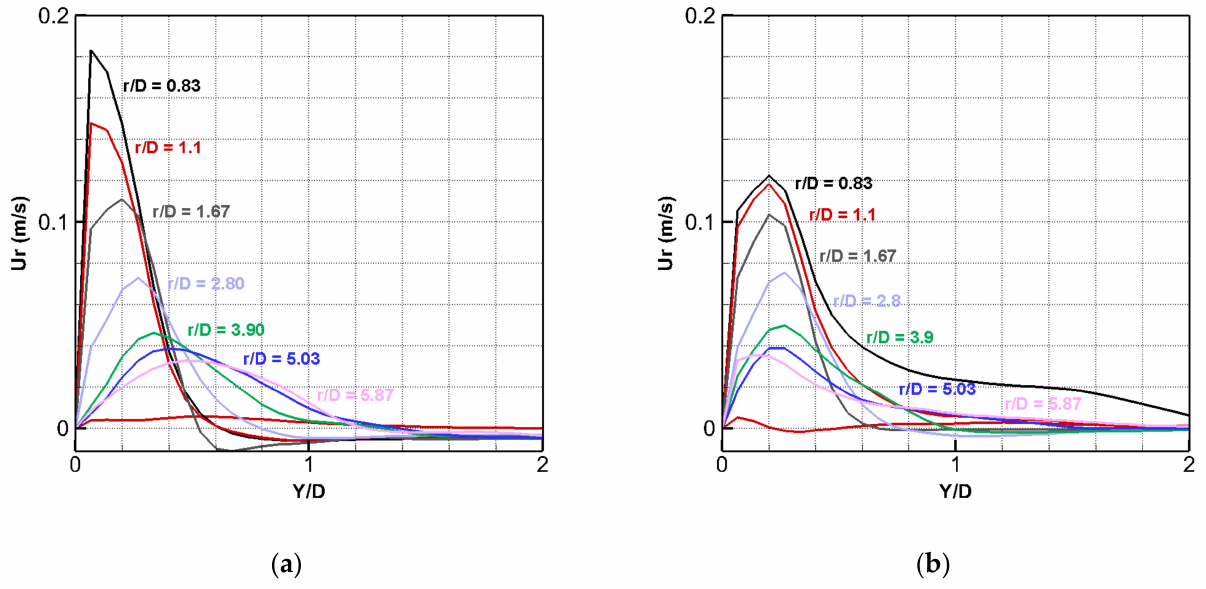
Figure 2. Mean radial velocity profiles for the impinging jet onto ( a ) stationary and ( b ) rotational disk (200